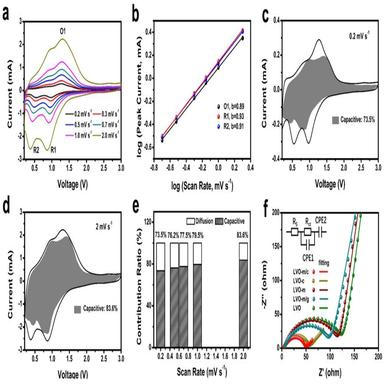
(a) CV curves of LVO-m/c at different scan rates. (b) The plots of log (peak current) versus log (scan rate). (c, d) The capacitive contribution (shade region) of LVO-m/c. (e) Contribution ratio of diffusion and capacitive at different scan rates. (f) Nyquist plots of LVO-m/c, LVO-c, LVO-m, LVO-m/g and LVO electrode. Inset: the equivalent circuit.